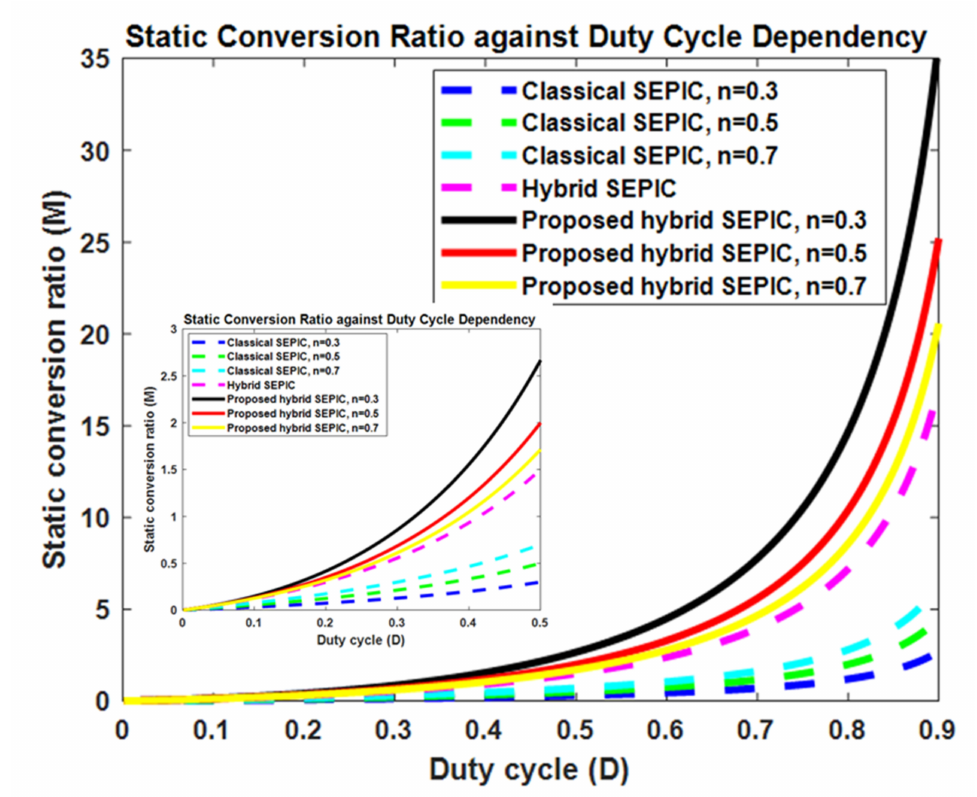
Figure 7. Static conversion ratio against the duty cycle for the classical isolated SEPIC, hybrid SEPIC and proposed converter with the turns ratio as a